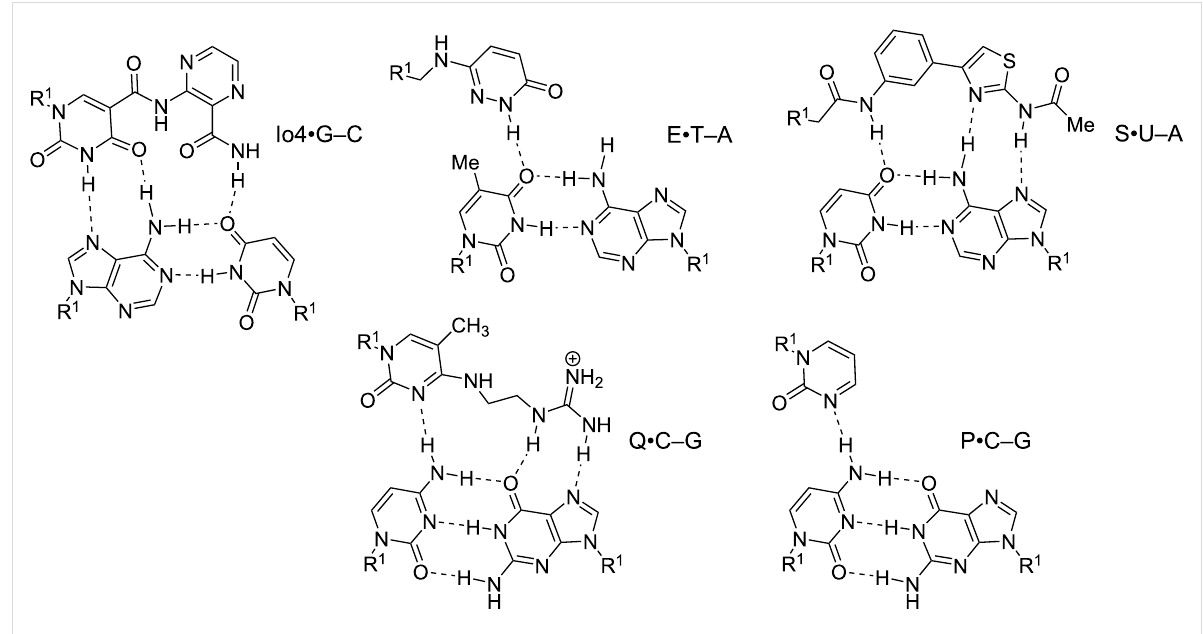
Figure 7: Proposed hydrogen bonding schemes for modified PNA nucleobases designed to recognize pyrimidines or the entire Hoogsteen face of the Watson–Crick base pairs. R 1 denotes DNA, RNA, or PNA backbones.